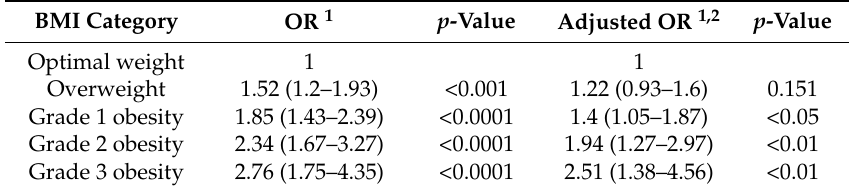
Table 4. Crude and adjusted odds ratios and 95% CIs of osteoporosis for different BMI categories (optimal weight was chosen as a reference group, with assigned value =